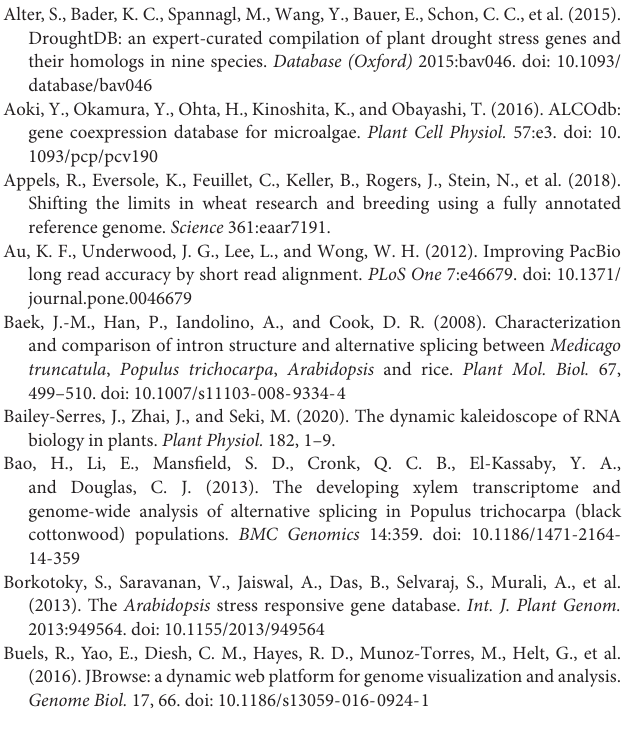
Supplementary Figure 3 | Principal component (PC) analysis plots for different tissues and datasets. Different shape means different datasets. Different color means different tissue. “SDX” group represent Stem Differentiating Xylem. Supplementary Figure 4 | The distribution of the Pearson Correlation Coefficient of stress-responsive genes under stress.